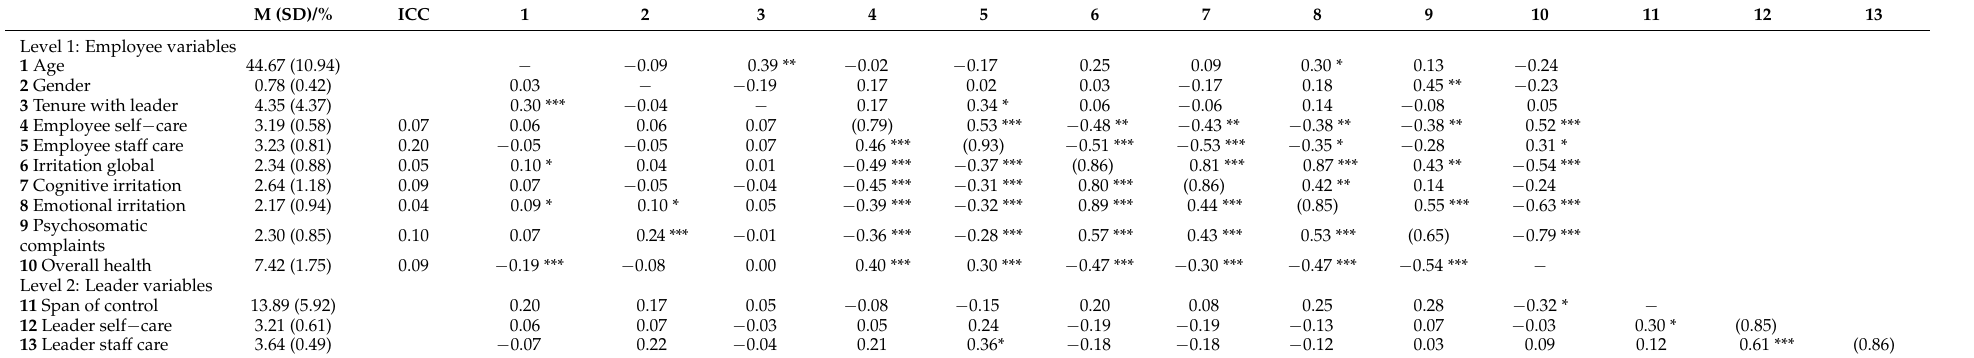
Table 1. Descriptive statistics and bivariate correlations between all study